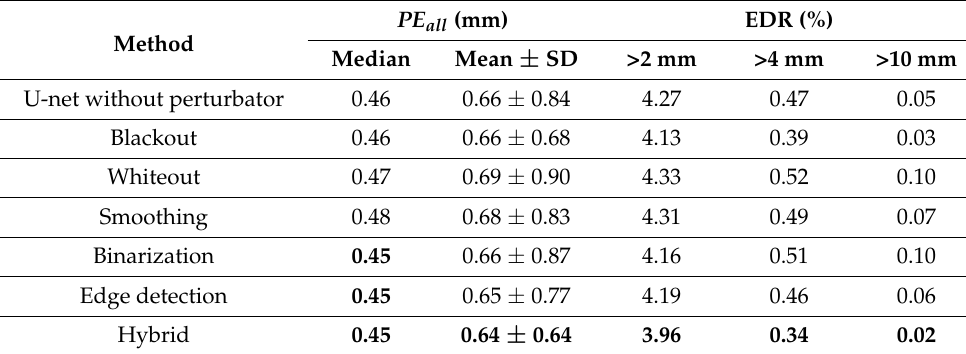
Table 3. Localization results according to perturbator on the Digital Hand Atlas